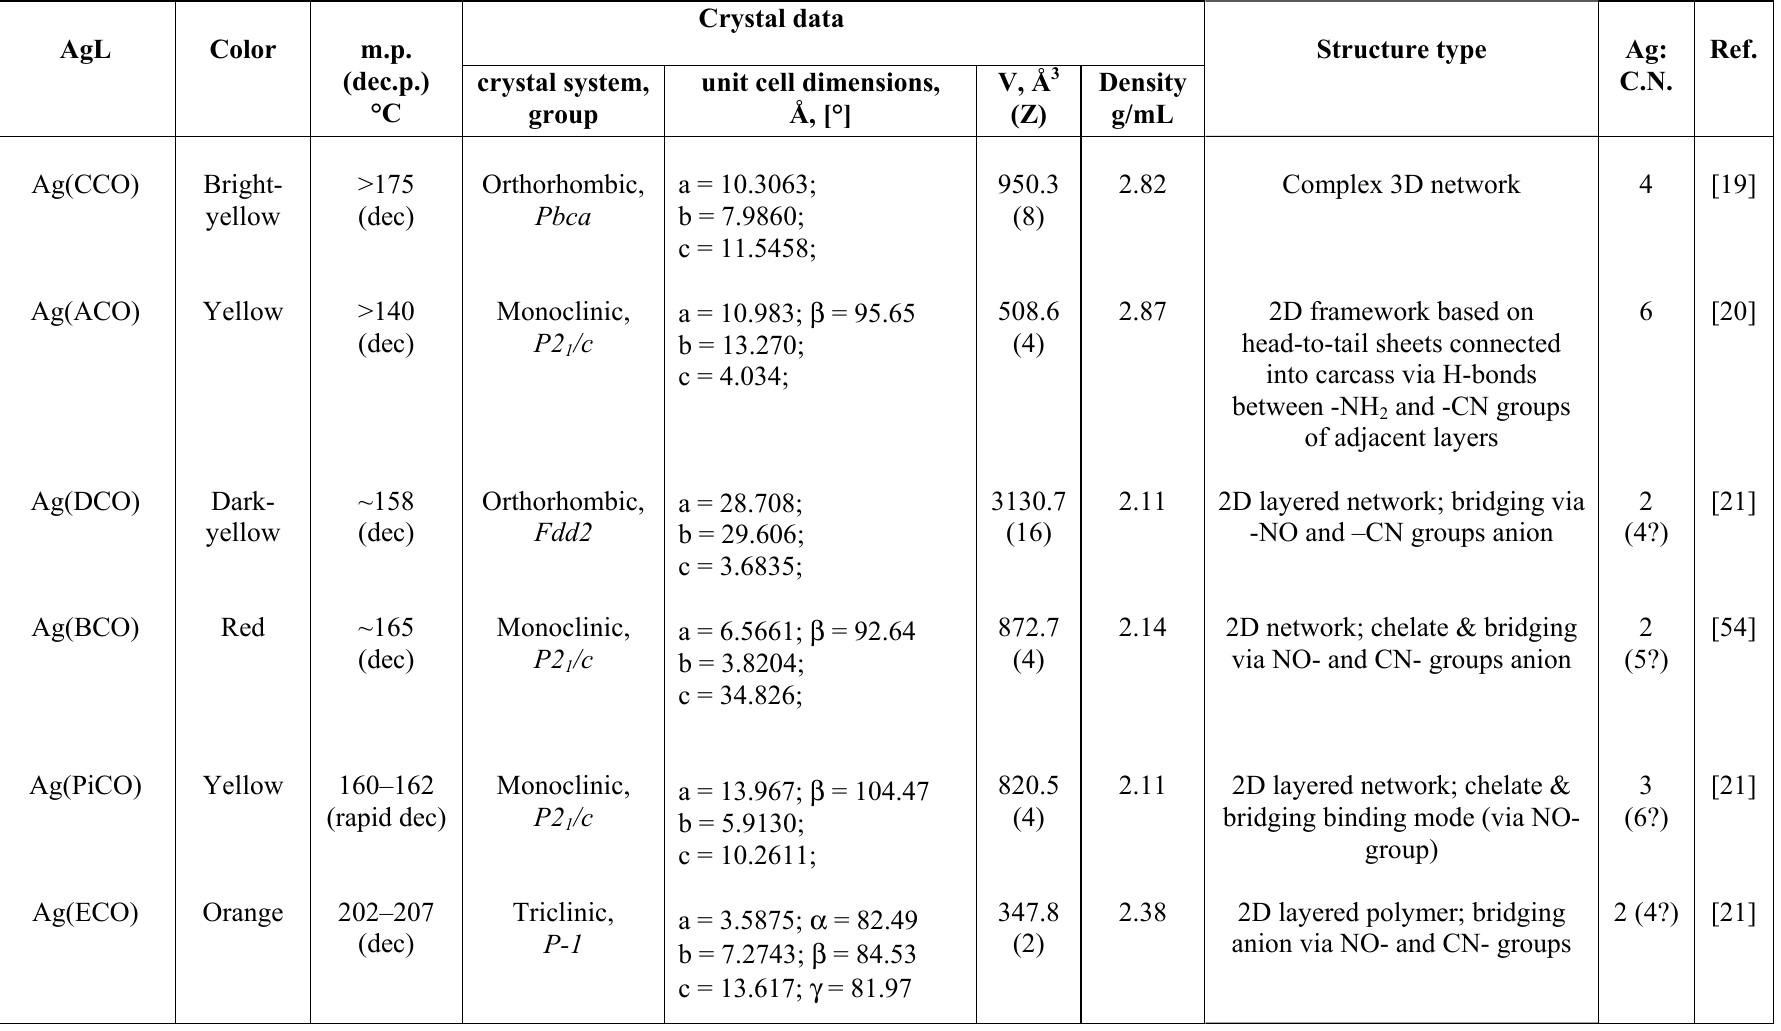
Table 4. Some chemical-physical parameters and crystal structures data for known polymeric Ag(I)